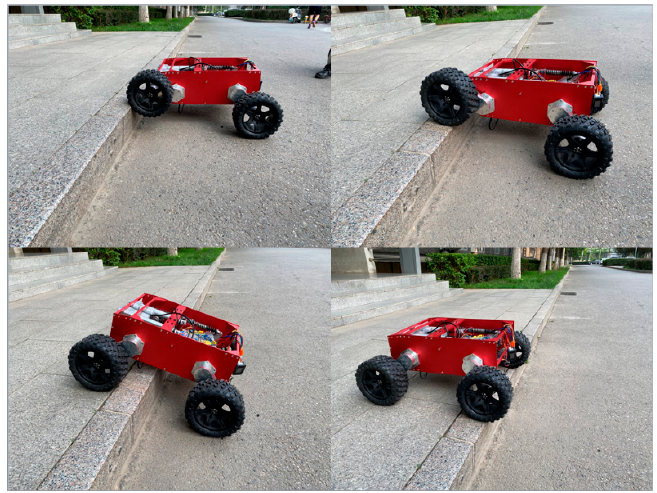
Figure 17. Robot vertical obstacle crossing experiment.